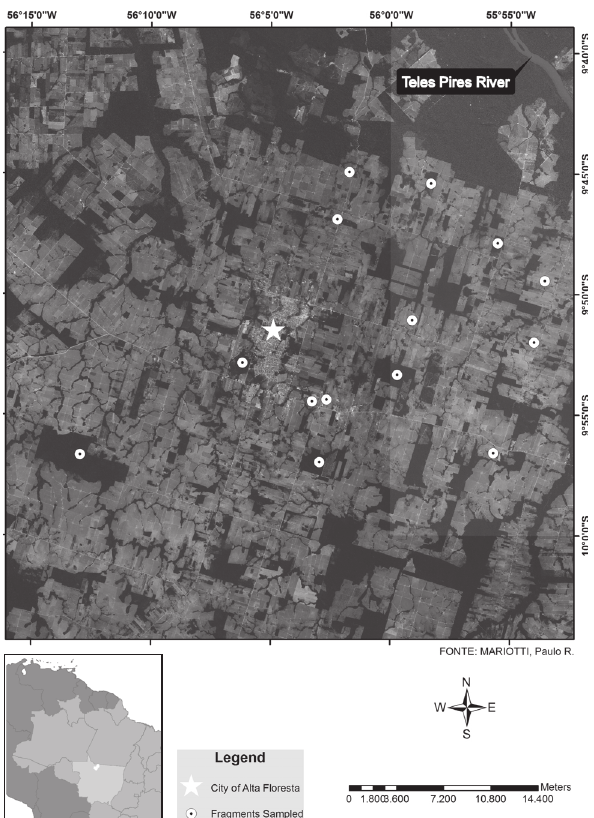
Figure 1. Forest fragments in Alta Floresta, Mato Grosso,